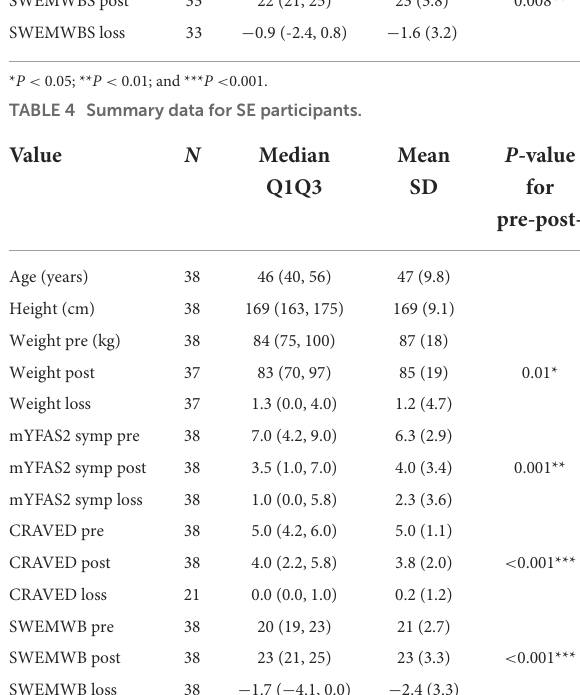
*P<0.05;**P<0.01;and***P<0.001.